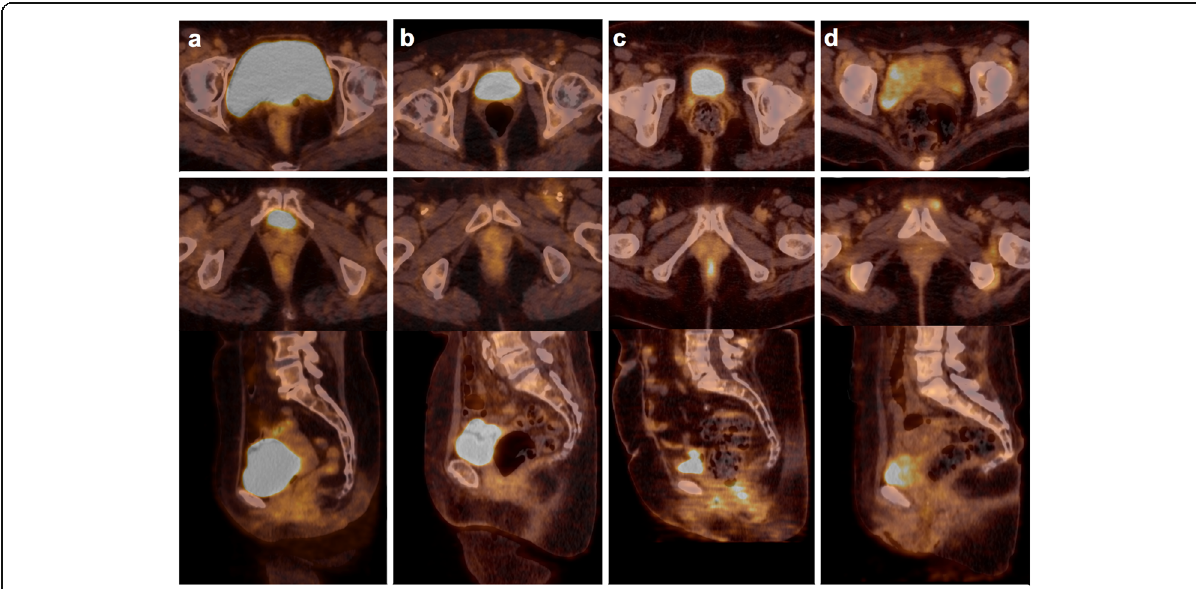
Fig. 4 Illustration of rectal content classification and its association with anal canal uptake. a Empty rectum. b Air rectal content classified 0. c